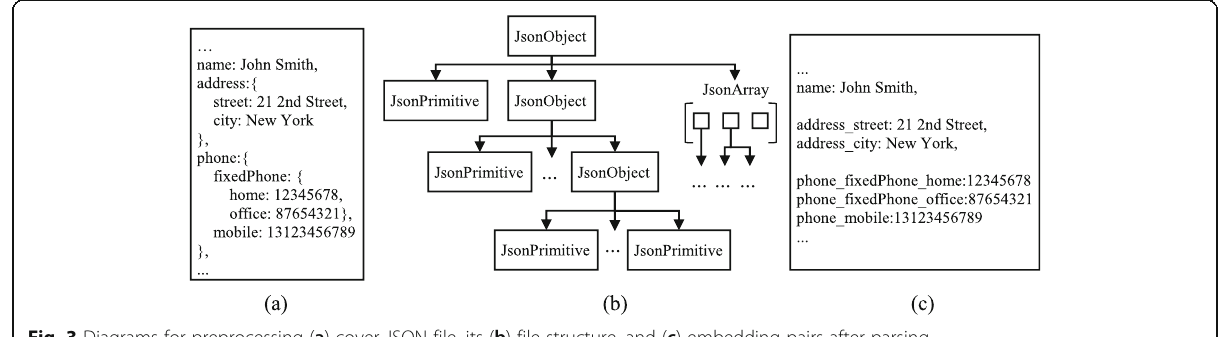
Fig. 3 Diagrams for preprocessing ( a ) cover JSON file, its ( b ) file structure, and ( c ) embedding pairs after